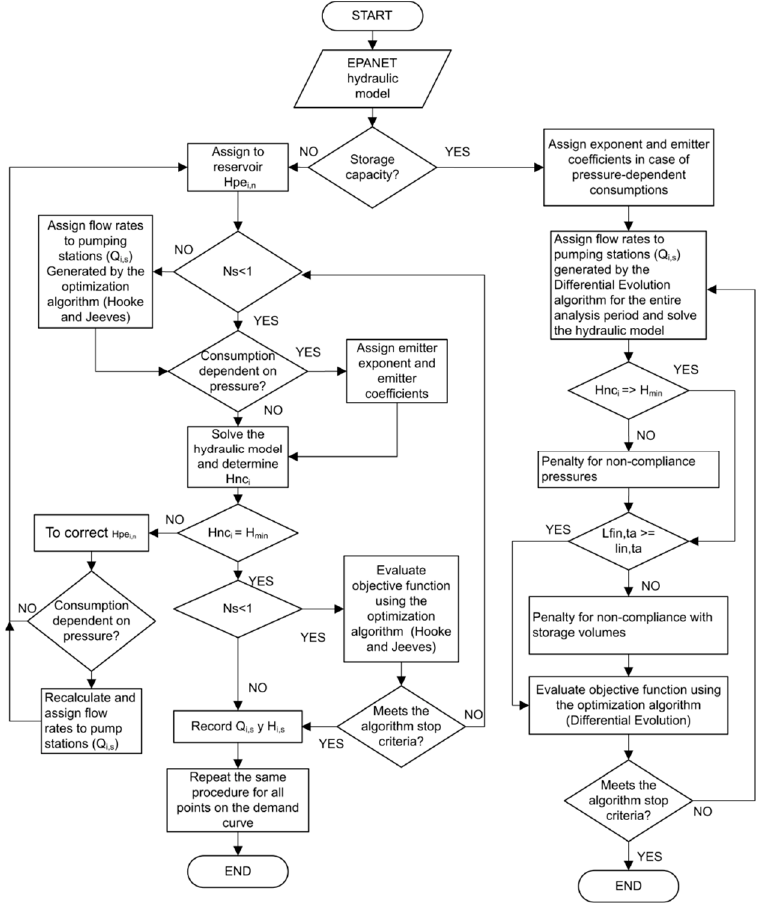
Figure 1. General flow chart of the cost minimization process.